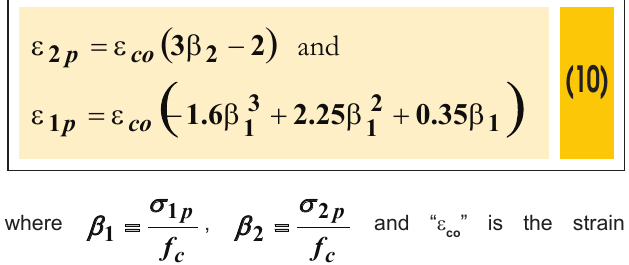
Figure 2 – Stress envelope of concrete on biaxial state of